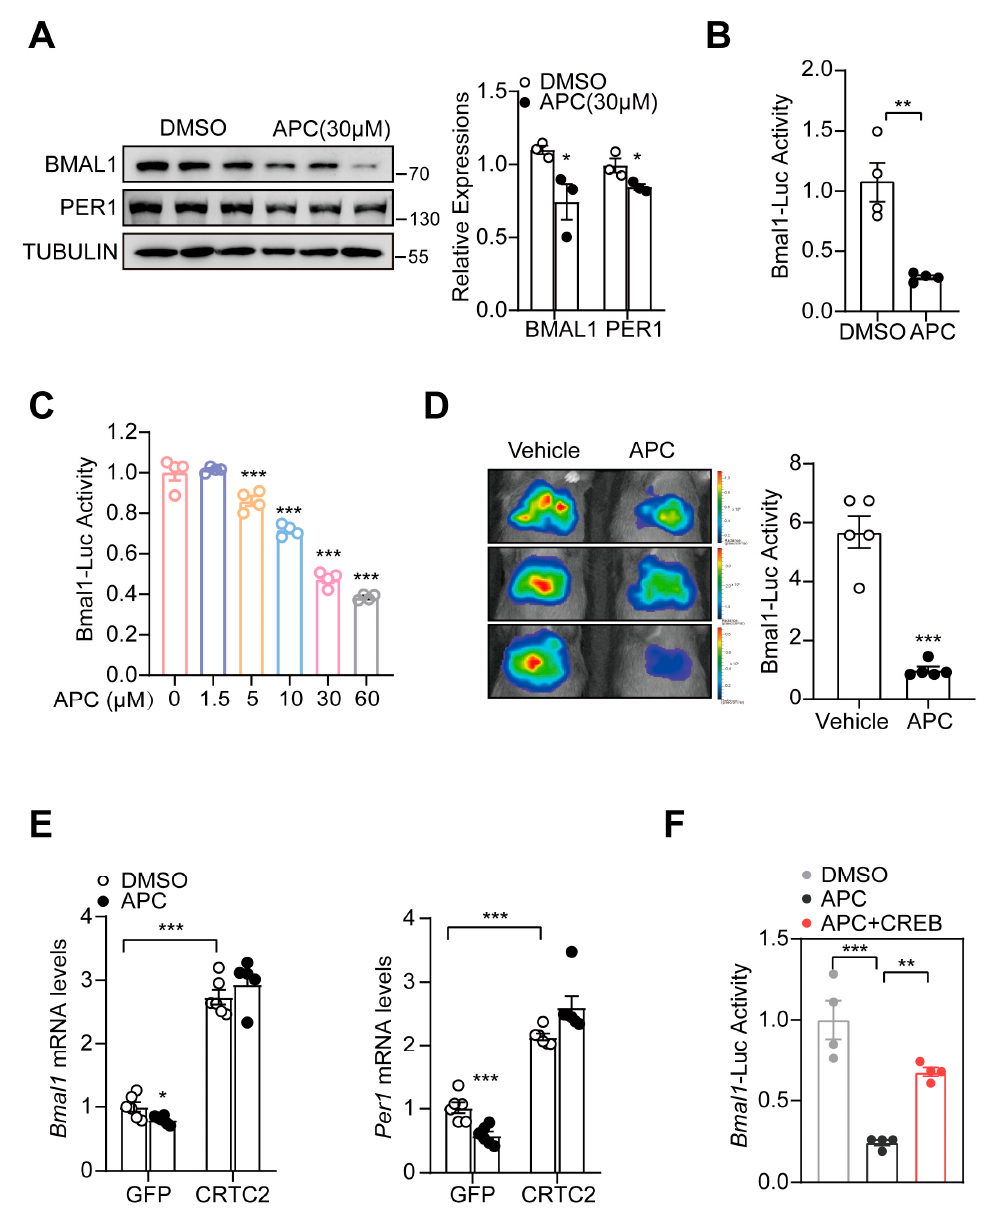
Figure 2. APC inhibits hepatic BMAL1 expression: ( A ) immunoblotting of BMAL1 and PER1 proteins in primary hepatocytes treated with 1 h of DMSO or APC (30 µ M) treatment prior to 7 h glucagon stimulation (100 nM, n = 3 per treatment); ( B ) luciferase Bmal1 − Luc activity; HEK293T cells were infected with Bmal1 − Luc and RSV −β− Gal for 24 h, followed by 1 h incubation with APC (30 μ M) prior to 7 h forskolin treatment before the luciferase assay ( n = 4 per treatment); ( C ) primary hepatocytes were infected by AD − Bmal1 − Luc and AD − RSV −β− Gal for 24 h, followed by 1 h incubation with APC (0, 1.5, 5, 10, 30, 60 μ M) prior to 7 h glucagon stimulation (100 nM, n = 4 per treatment) Different colors represent different group treated with different concentrations of APC.; ( D ) live imaging assay of Bmal1 − Luc activity in WT mice; the mice were tested at ZT1; ( E ) mRNA levels of Bmal1 and Per1 analyzed by real − time qPCR in primary mouse hepatocytes. The cells were injected with GFP − and CRTC2 − expressing adenovirus for 24 h and treated with APC for 1 h prior to 8 h glucagon stimulation (100 nM, n = 6 per group); ( F ) luciferase Bmal1 − Luc activity; HEK293T cells were infected with Bmal1 − Luc, CREB, and RSV −β− Gal for 24 h, then incubated with APC (30 μ M) for 1 h prior to forskolin 7 h before luciferase assay ( n = 4 per treatment). * p < 0.05; ** p < 0.01; *** p < 0.001.